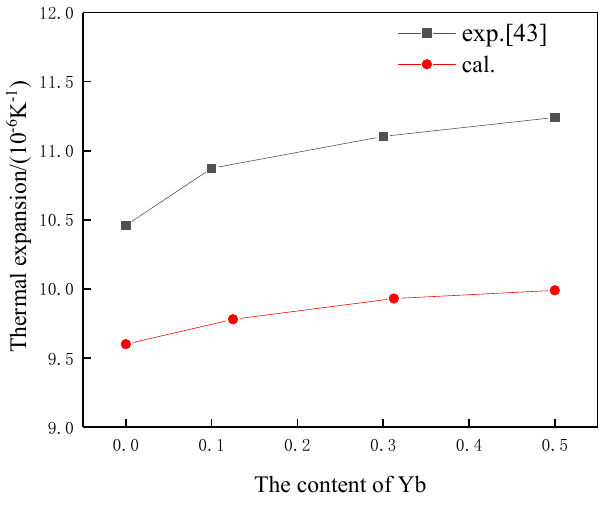
Figure 4. α ∞ and α of (Gd 1-x Yb x ) 2 Zr 2 O 7 .